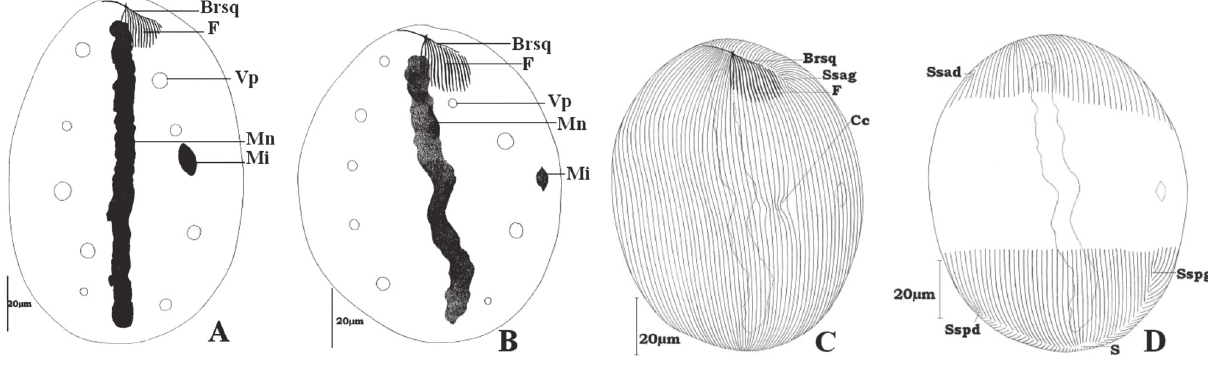
Figure 3. – Paracoelophrya polymorphus n.